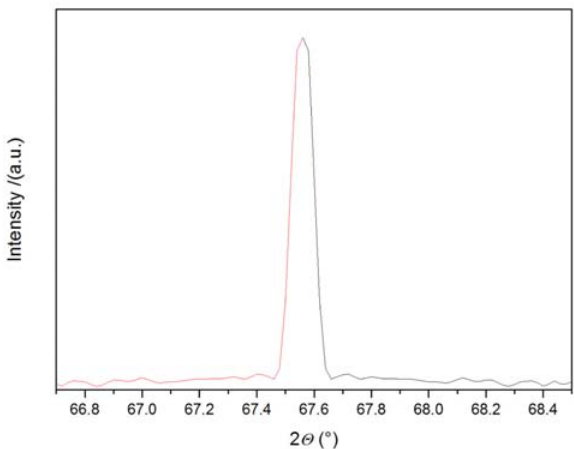
Figure 11. The result of the analysis for the right-hand profile.